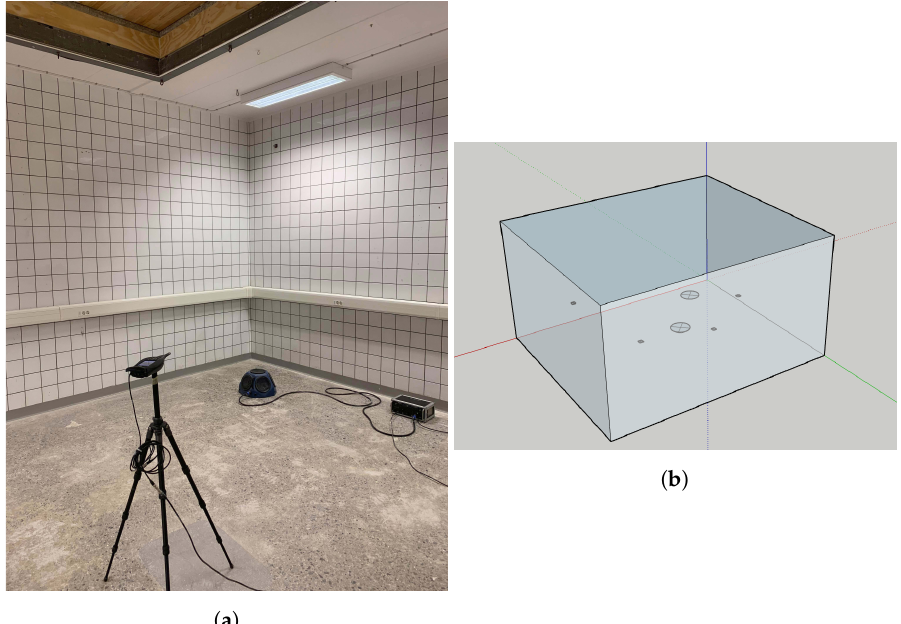
Figure 2. Photograph of a measurement setup ( a ) in the space measured in this project, although the suspended ceiling of acoustic absorbers was not installed at the time of this picture. Note that the speaker depicted is semi-dodecahedral, whereas the speaker actually used was dodecahedral. ( b ) shows the digital model of the same space with source (circular) and listener (small squares) positions